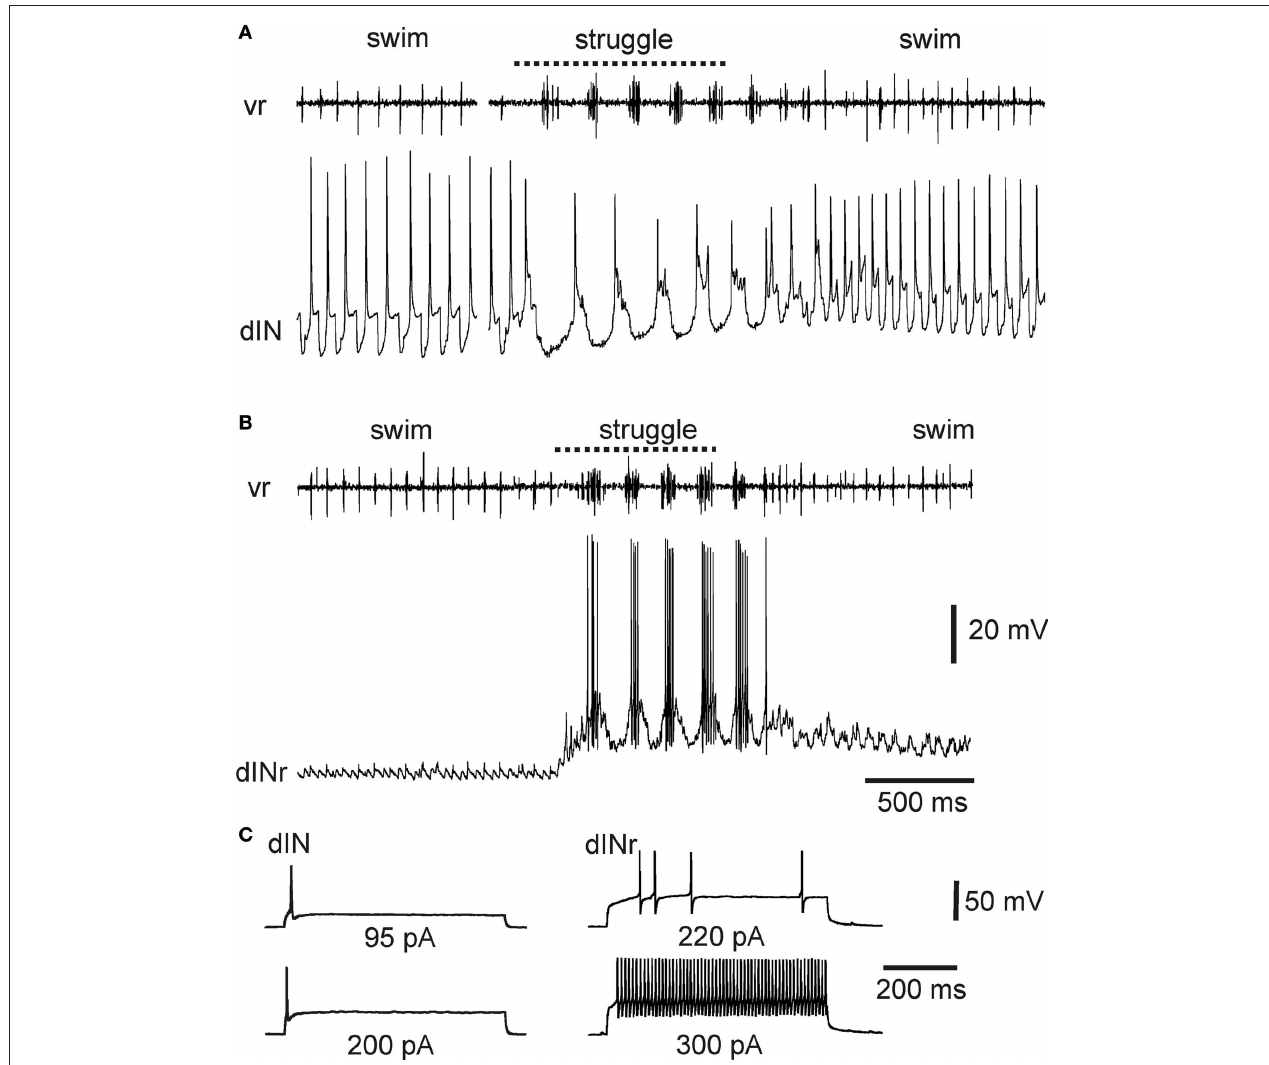
swimming and does not fire, but is recruited to fire strong rhythmic bursts during struggling. (C) Contrasting firing activity in a dIN and dINr in response to depolarizing current. The dIN fires only once; the dINr can fire repetitively at high frequency (see Li et al.,